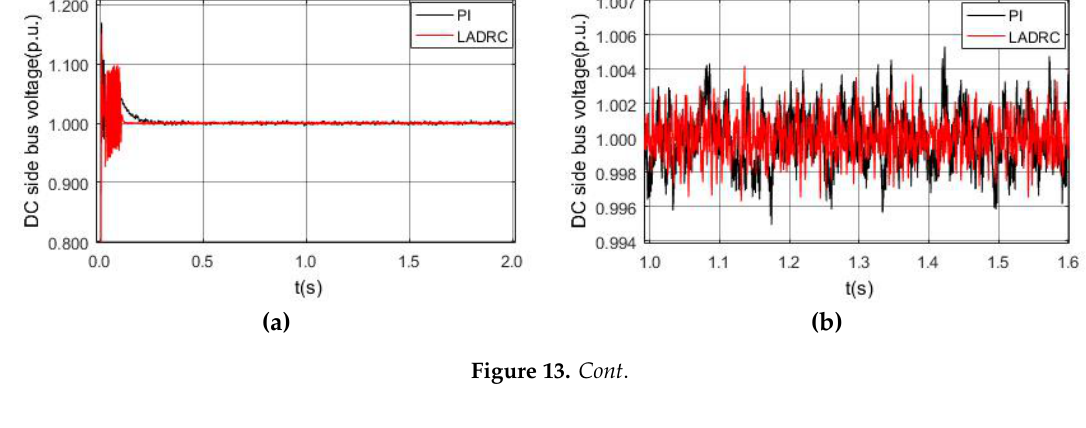
q -axis corresponding to the change of q -axis actual current.